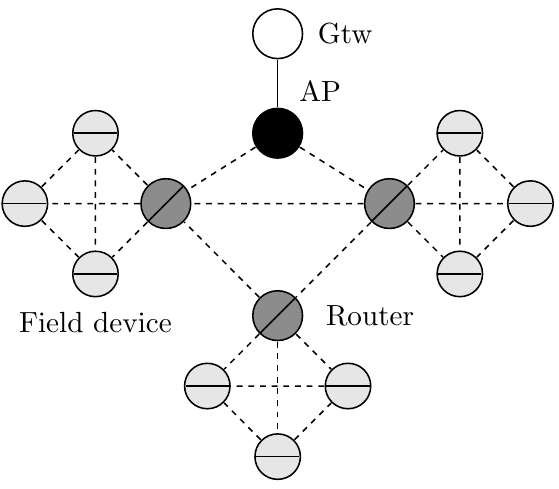
Figure 20. Typical cluster topology for a Wireless Sensor Network.